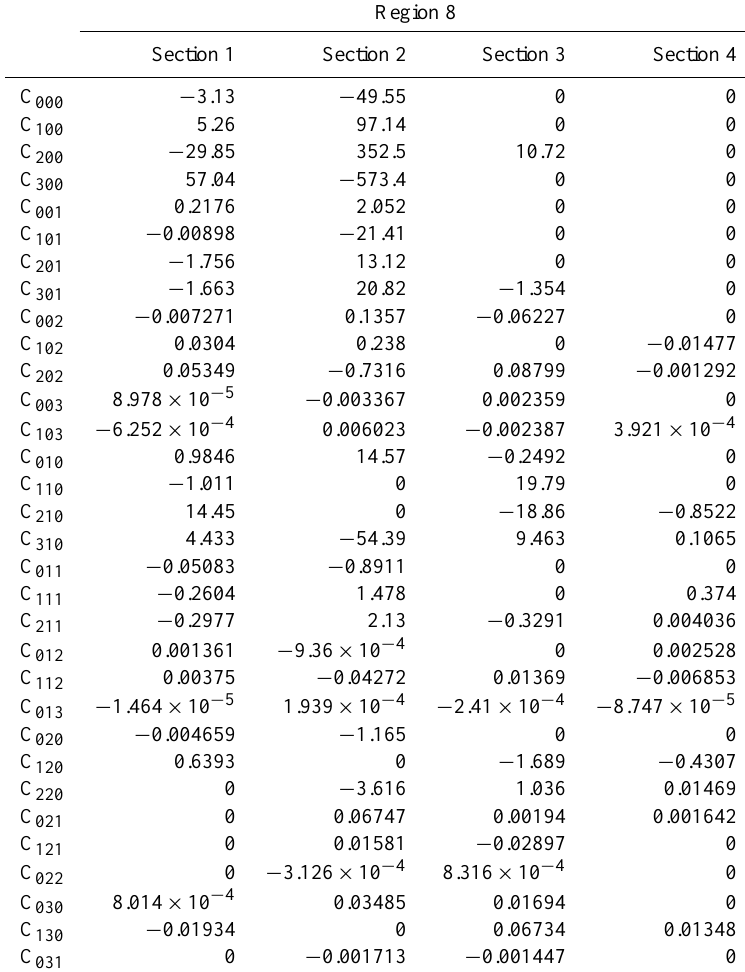
Table 10. Similar to Table 3, but for region